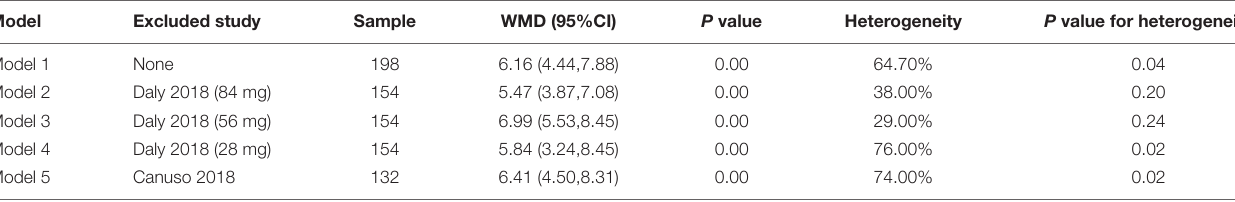
TABLE 2 | Sensitivity analyses for MADRS score decreased from baseline to 2–4 h.